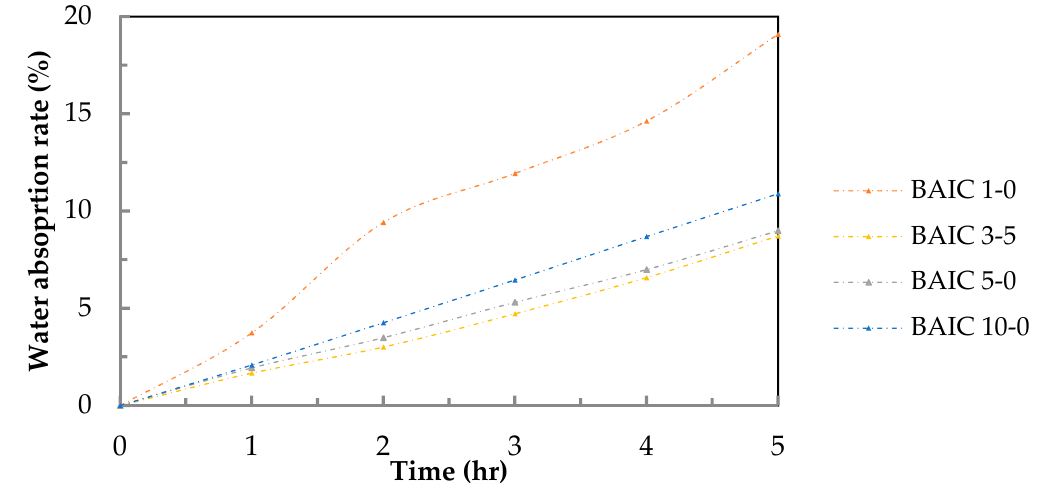
Figure 12. Water absorption rate of BAIC